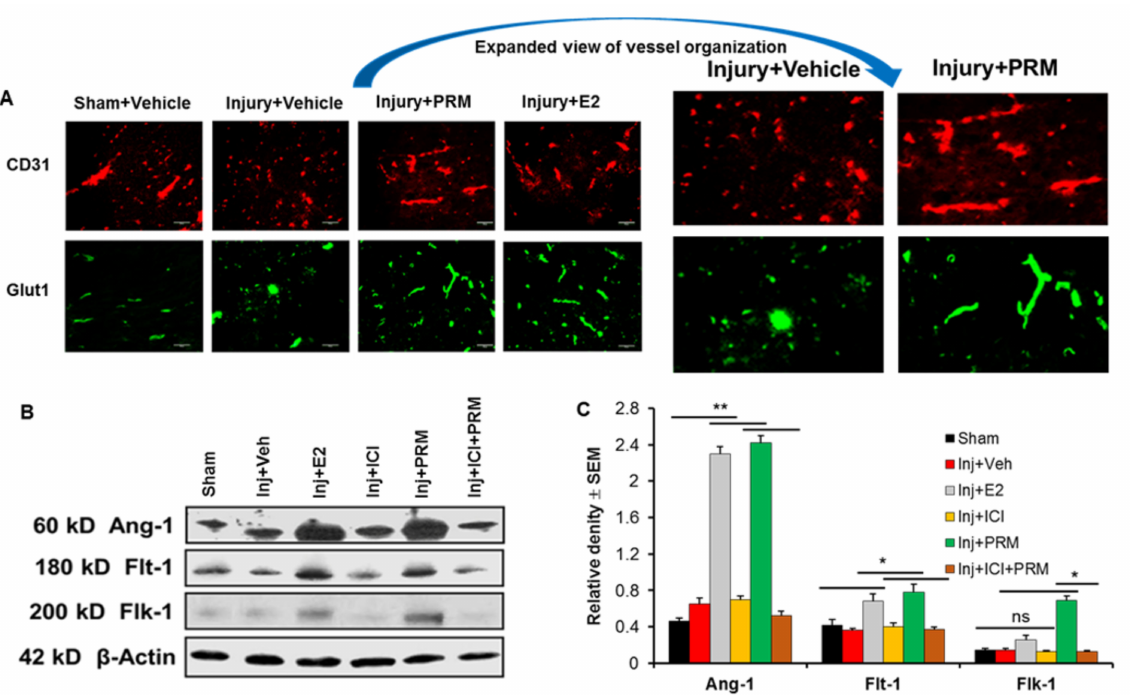
Figure 8. PRM treatment for 7 days increased the expression of CD31 and GLUT1 angiogenic markers in SCI. ( A ) PRM improved angiogenesis in penumbra at day 7 post-SCI indicated by an increase in immunostaining of the angiogenesis markers CD31 and GLUT1. Expanded view of CD31 and GLUT1 in injury + vehicle vs. injury + PRM represents marked differences in vessel organization. The effect of PRM on increased angiogenesis was similar to that observed in E2-treated rats (positive control) following SCI. Representative immunofluorescent staining images using antibody against CD31 (red) and GLUT1 (green) are shown (magnification, 200 × , n = 4–6). ( B ) PRM treatment also increased the expression of other angiogenesis-related proteins, such as Ang-1, Flt-1, and Flk-1, as shown by representative western blotting. ( C ) E2 and PRM significantly increased angiogenic markers in injured spinal cord as determined by densitometric analysis using ImageJ software, NIH, Bethesda, MA, USA). * p < 0.05, ** p < 0.01. ns = not